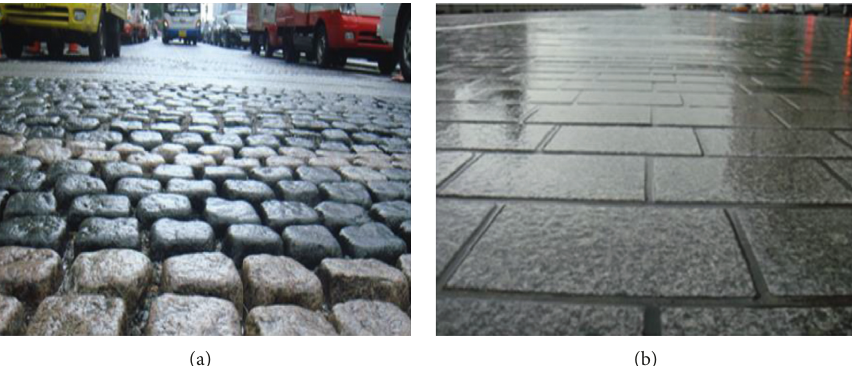
Figure 1: Classification of construction methods for stone element pavement. (a) Flexible surface construction (cubes). (b) Rigid surface construction (setts).